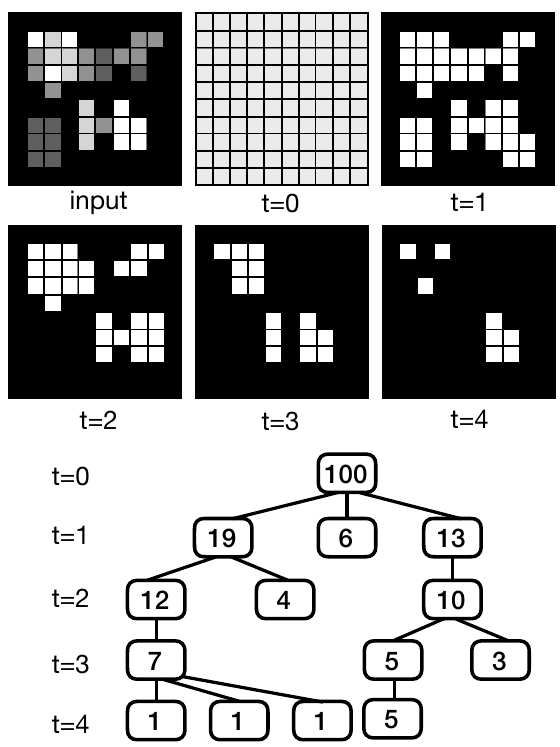
Figure 3. A gray-level input and its successive threshold sets from t = 0 to t = 4, where d = 1. Below is the component tree with each node showing the size of its connected